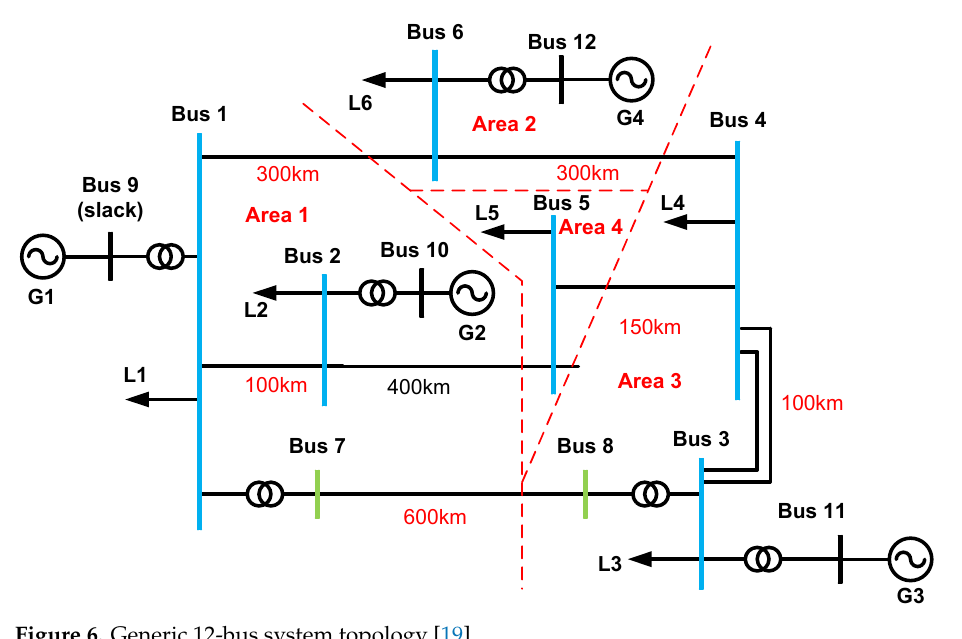
Figure 6. Generic 12-bus system topology